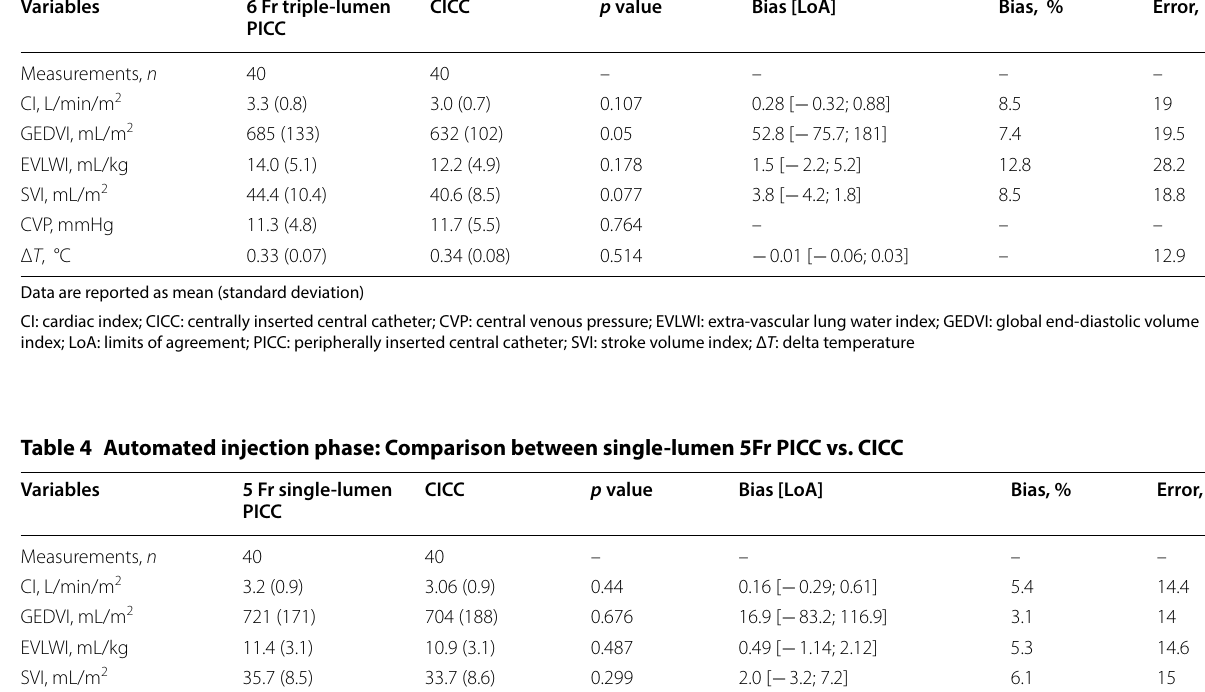
Table 3 Manual phase: Comparison between triple-lumen 6Fr PICC vs. CICC